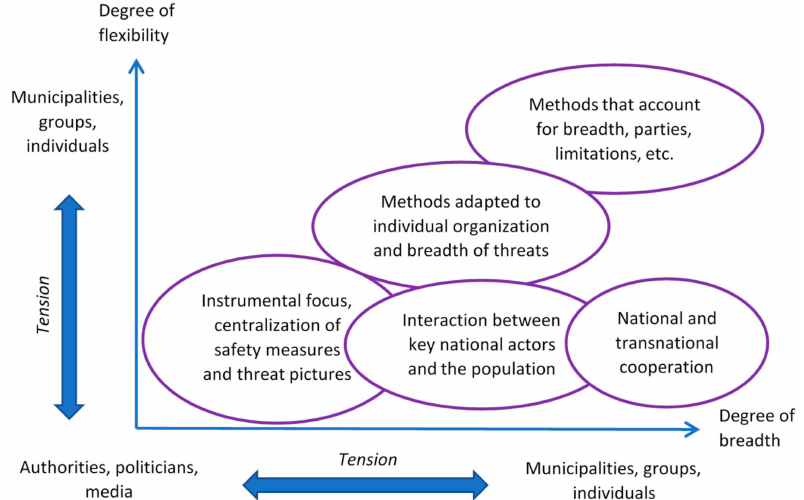
Figure 1. Illustration of the breadth and flexibility space and tension among actors/forces in the work on samfunnssikkerhet. The content of the oval shapes is derived from the four identified